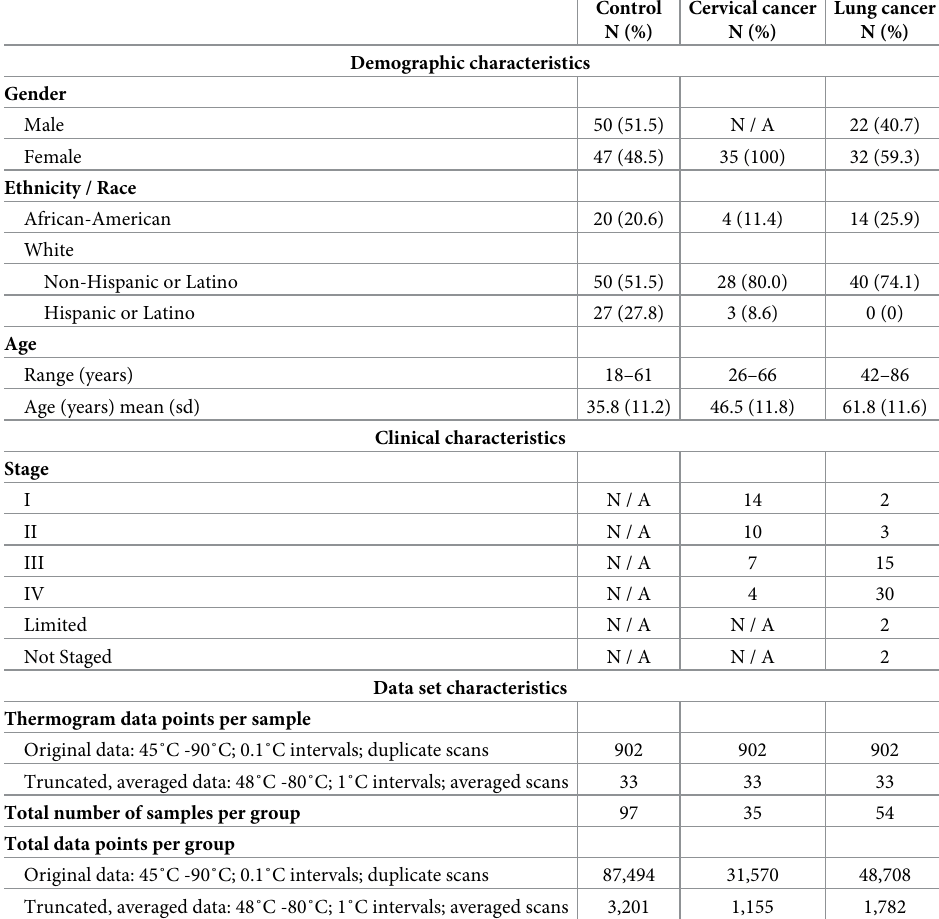
Table 1. Demographic, clinical and data characteristics of the study